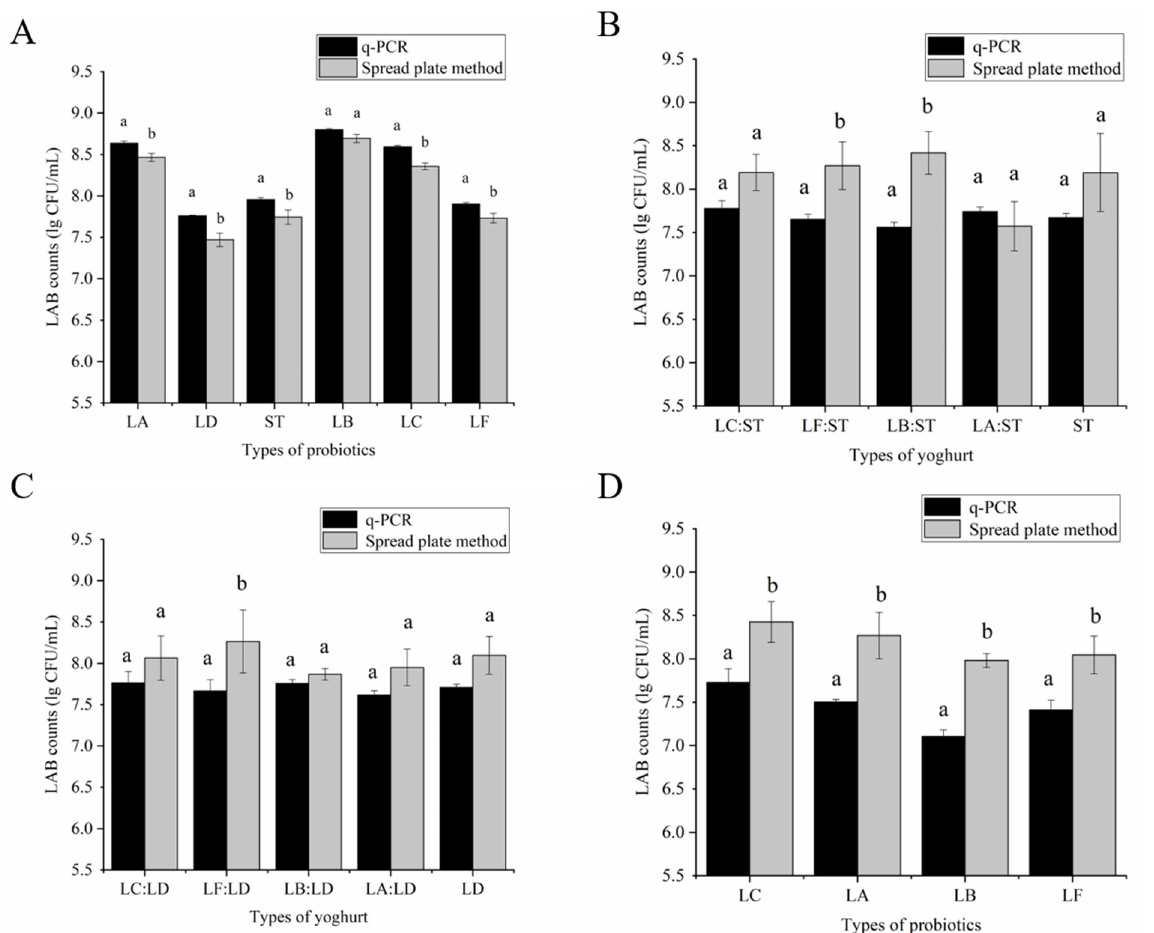
Figure 5. Comparison of spread plate method and qPCR. ( A ): Comparison in the enumeration of six species of LAB monobacterial fermentation. ( B ): LC:ST, LF:ST, LB:ST, LA:ST, and ST; counting ST was represented in yogurt fermented by different combinations of LC + LD + ST, LF + LD + ST, LB + LD + ST, LA + LD + ST, and LD + ST, respectively. ( C ): the LDs in yogurt fermented with different strain combinations were counted. ( D ): indicated that LC, LA, LB, and LF were counted separately in yogurt fermented by different combinations of strains. If p < 0.05 indicated a significant difference, p ≥ 0.05 indicated that the difference was not significant, the letter “a, b” were used for significance marking.